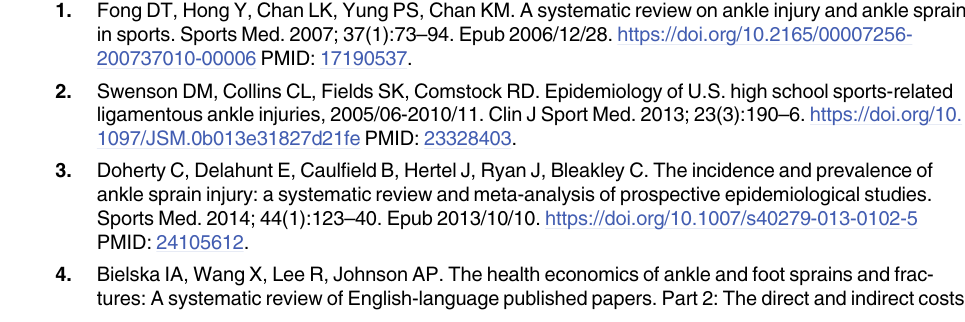
S1 Table. Search strategies. Search terms for all six databases. S2 Table. List of excluded studies during full-text